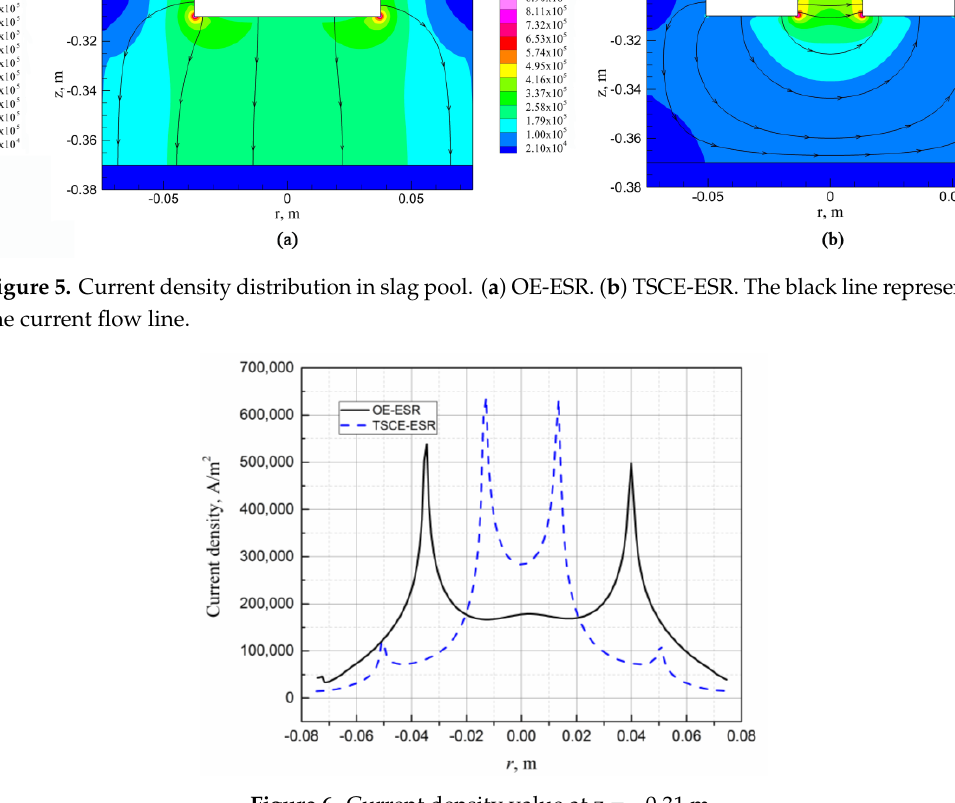
Figure 6. Current density value at z = −0.31 m.